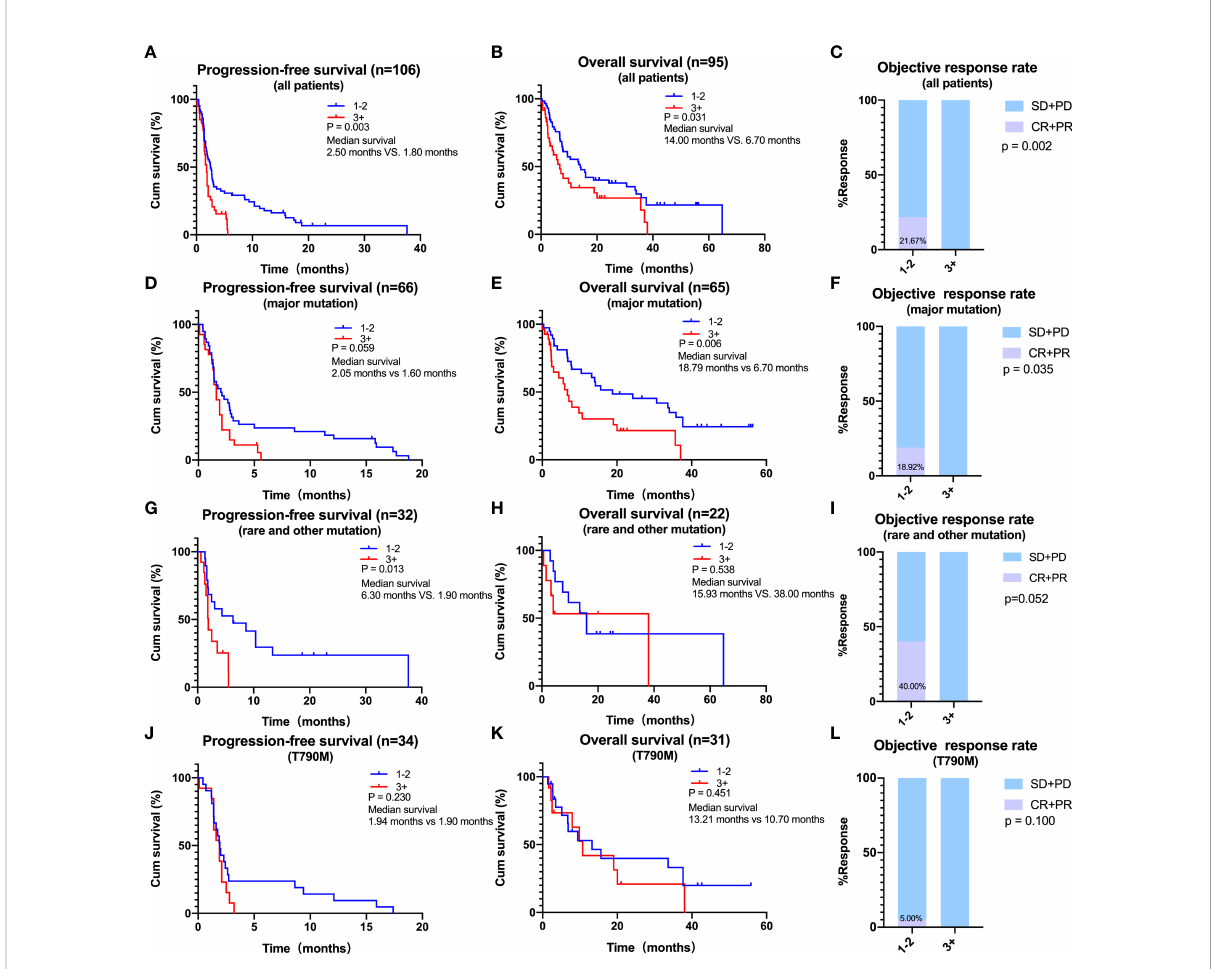
FIGURE 4 Effects of prior lines of therapy on the ef fi cacy of immune checkpoint inhibitors. (A – C) In all patients, progression-free survival (PFS) (A) , overall survival (OS) (B) , and objective response rate (ORR) (C) of patients with 1 – 2 or ≥ 3 lines of therapy. (D – F) In patients harboring major mutations, PFS (D) , OS (E) , and ORR (F) of patients with 1 – 2 or ≥ 3 lines of therapy. (G – I) In patients harboring rare or other mutations, PFS (G) , OS (H) , and ORR (I) of patients with 1 – 2 or ≥ 3 lines of therapy. (J – L) In patients harboring T790M, PFS (J) , OS (K) , and ORR (L) of patients with 1 – 2 or ≥ 3 lines of